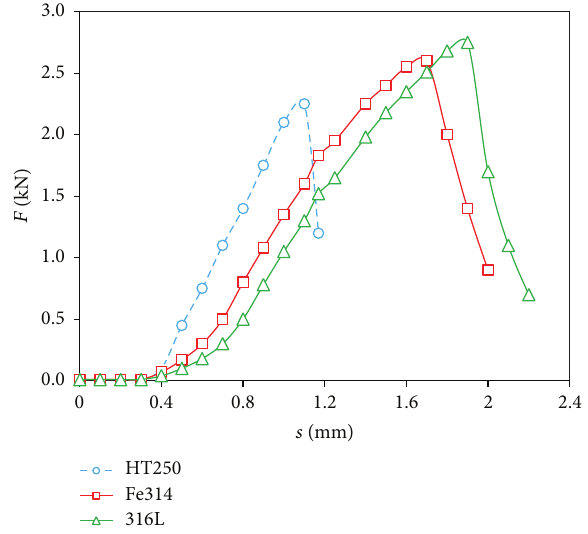
Figure 12: Load-displacement